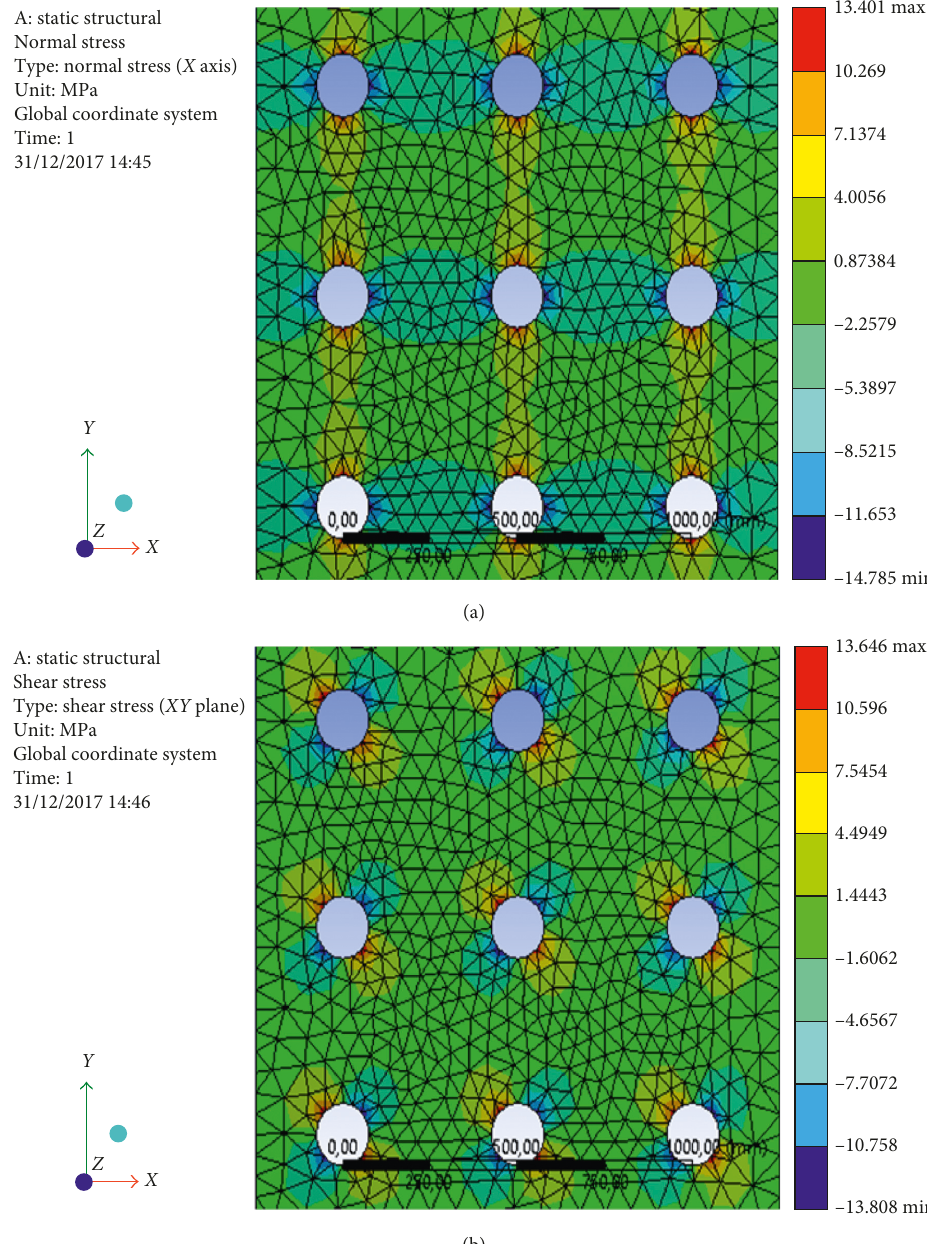
Figure 11: Redistribution and magnitude of stresses around 9 holes drilled in the square mesh. (a) Normal stress. (b) Shear